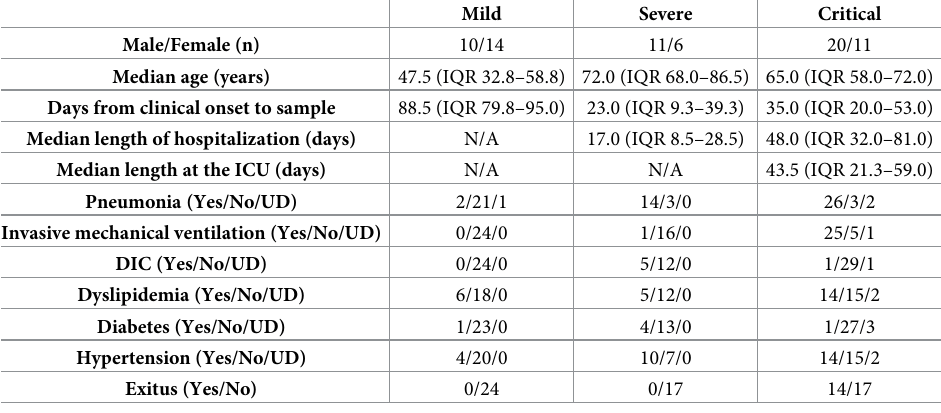
Table 1. Demographic and clinical data of participants with different presentations of COVID-19 who were recruited for the study.